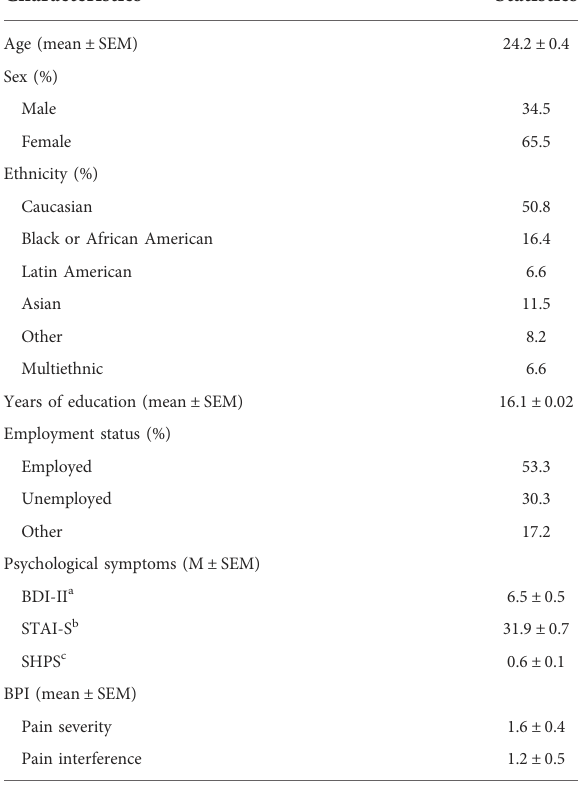
TABLE 1 Psychosocial characteristics of